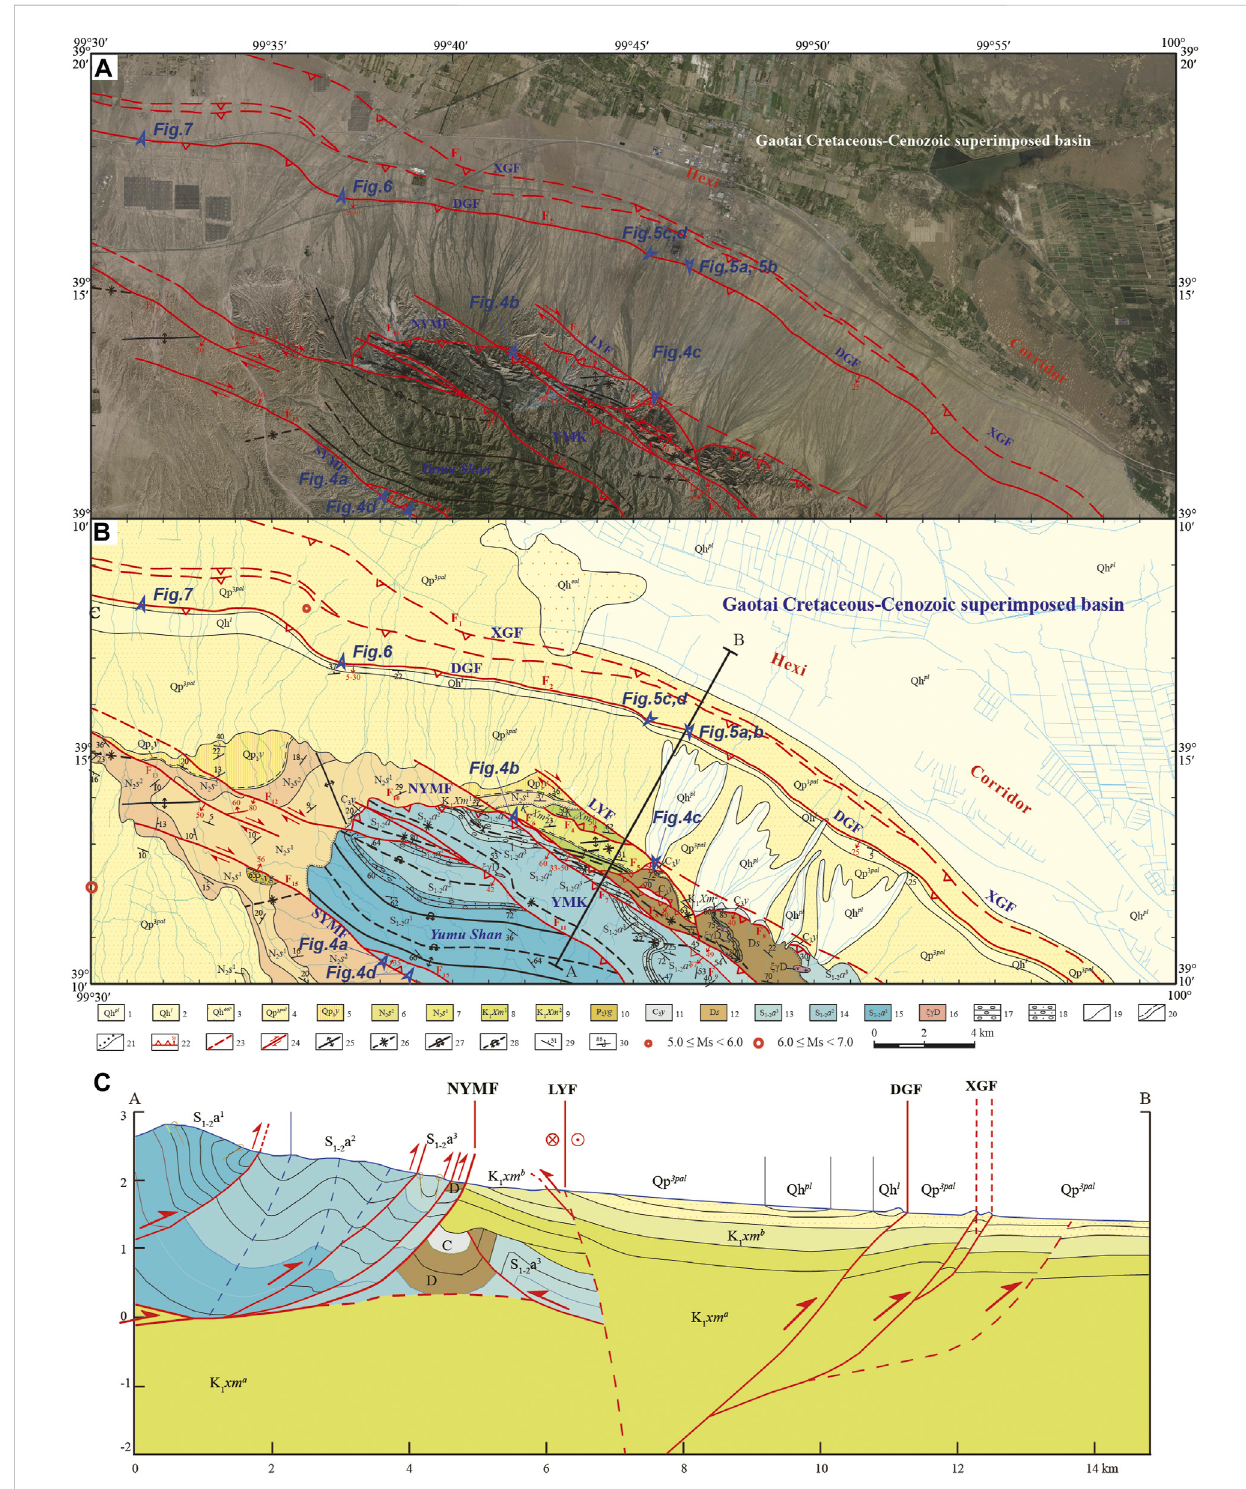
FIGURE 3 (A) Google Earth image of northern Yumu Shan. (B) Geological map of northern Yumu Shan based on our fi eld observations. Modi fi ed from Chen et al. (2019b) and (Wang et al., 2022). Historical earthquake events are from Ren et al. (2019). Legends: 1 — Holocene diluvial deposits; 2 — Holocene lacustrine sediments; 3 — Holocene aeolian sediments; 4 — alluvial – pluvial deposits of the Upper Pleistocene; 5 — Lower Pleistocene Yumen Formation; 6 and 7 — upper and lower members of the Neogene Shulehe Formation; 8 and 9 — upper and lower subgroups of the Lower Cretaceous Xinminpu Group; 10 — Middle Permian Yaogou Formation; 11 — Upper Carboniferous Yanghugou Formation; 12 — Devonian Shaliushui Formation; 13, 14, and 15 — third, second, and fi rst members of the Middle-Lower Silurian; 16 — Devonian syenogranite; 17 — conglomerate; 18 — sand conglomerate; 19 — geological boundary; 20 — parallel unconformity; 21 — angular unconformity; 22 — thrust fault; 23 — blind fault; 24 — strike – slip fault; 25 — anticline; 26 — syncline;27 — overturnedanticline;28 — overturnedsyncline;29 — bedding;30 — overturned bedding.LocationsofFigures4A – D – 4D,5A – D – 5D,6,7 are shown as rectangles. (C) Geological cross section (pro fi le A – B) from the Yumu Shan to the Hexi